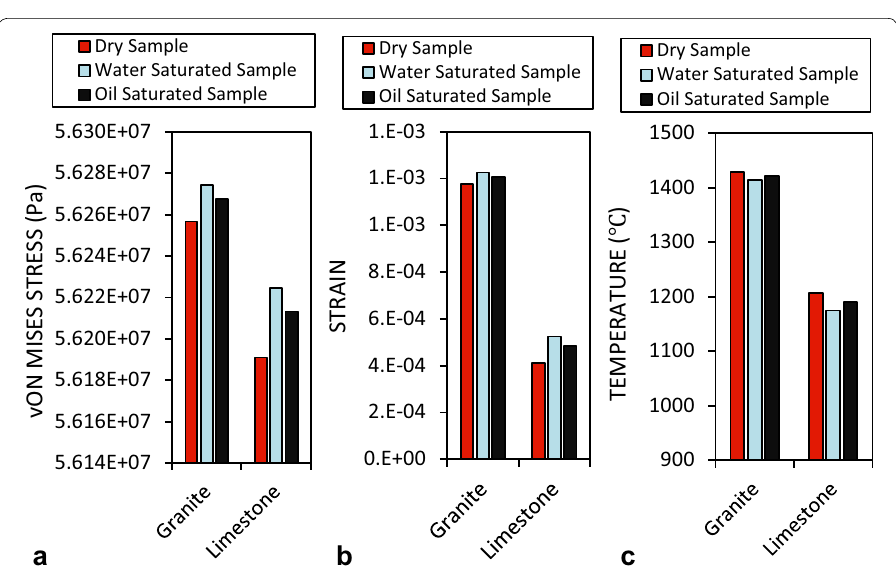
Fig. 10 a The graph of maximum stress, b maximum strain and, c maximum temperature created in samples of granite and limestone in dry, water-saturated and oil-saturated